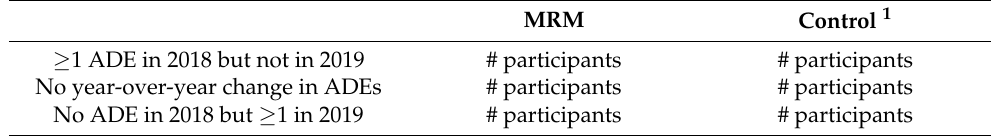
Table 2. Example contingency table.